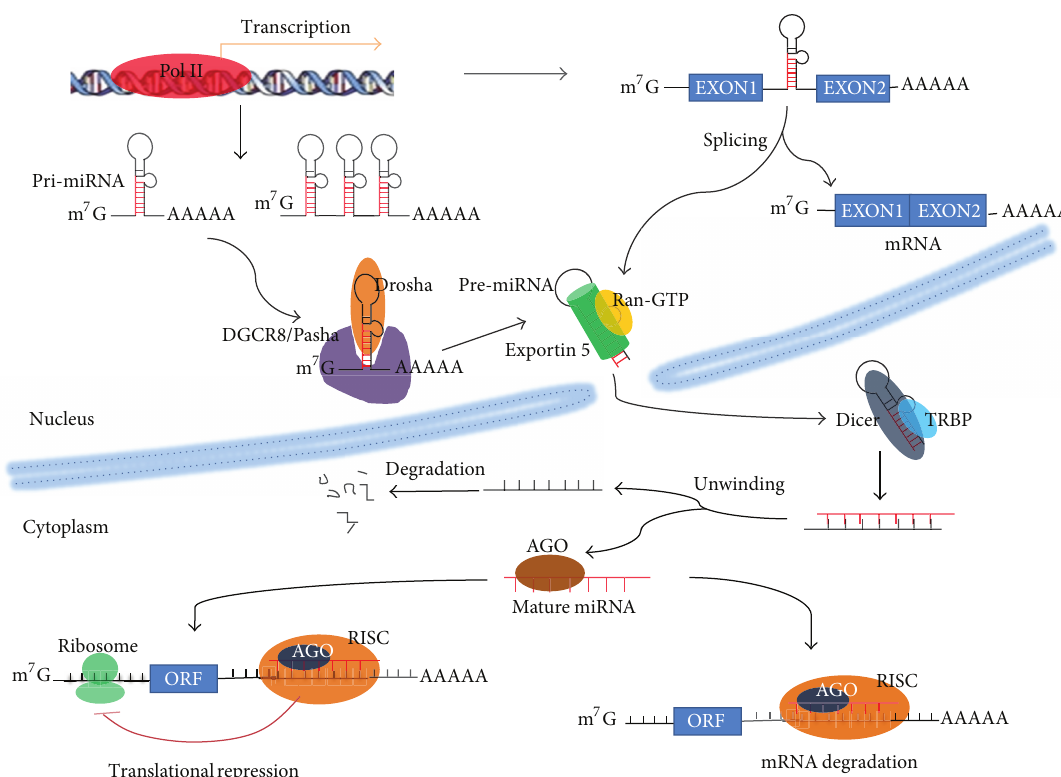
Figure 1: The biogenesis of microRNAs is summarized. Genes encoding microRNAs are transcribed mainly by Pol II (DNA-dependent RNA polymerase II) with the products as the pri-miRNAs that are processed into pre-miRNA by DGCR8/Drosha. Pre-miRNAs are exported into the cytoplasm where they are further converted into the mature forms by the TRBP/Dicer. Mature miRNAs bind to the target mRNAs to inhibit their expression. ORF: open-reading frame; RISC: RNA-induced silencing